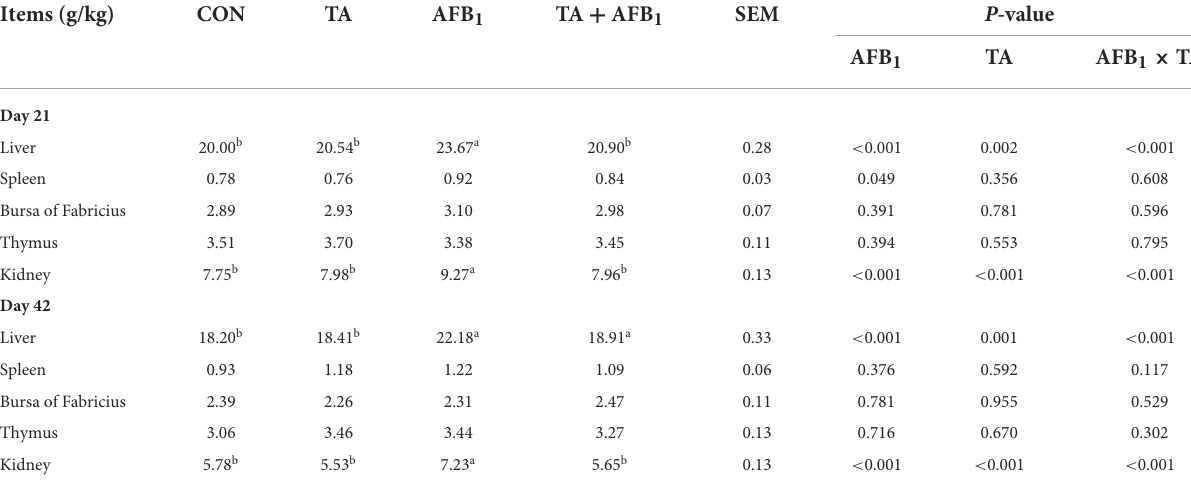
TABLE 3 Effects of tannic acid on relative organ weight of broilers challenged with AFB a 1